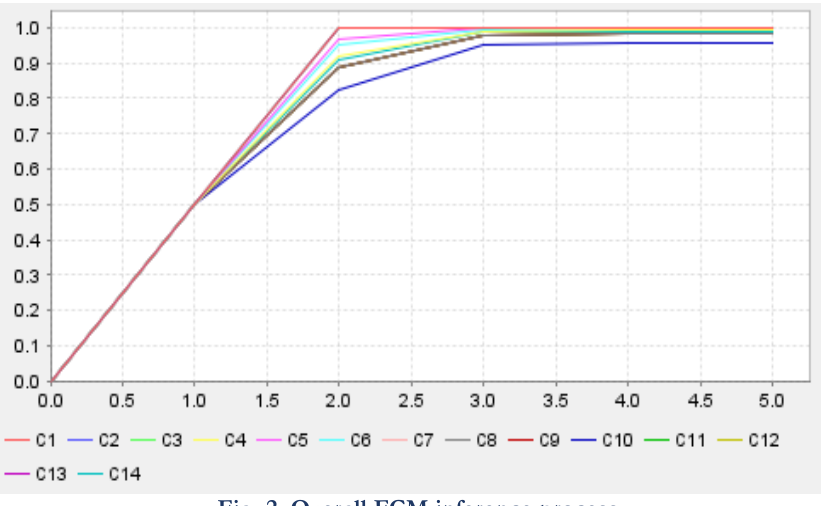
Fig. 2. Overall FCM inference process.